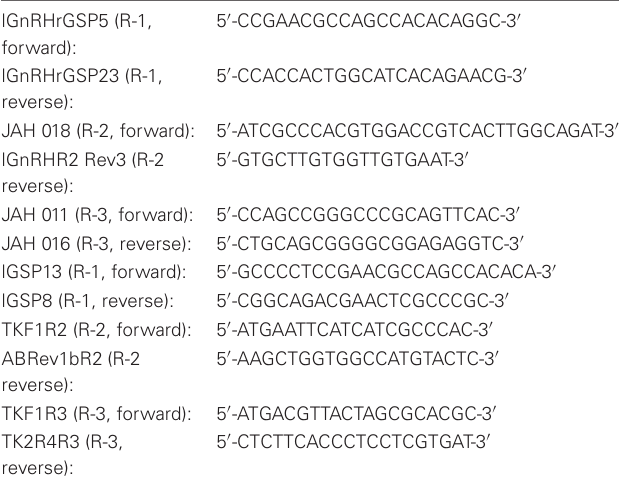
Table 1 | Sequences of the primers used in the various PCR and RNA probe synthesis